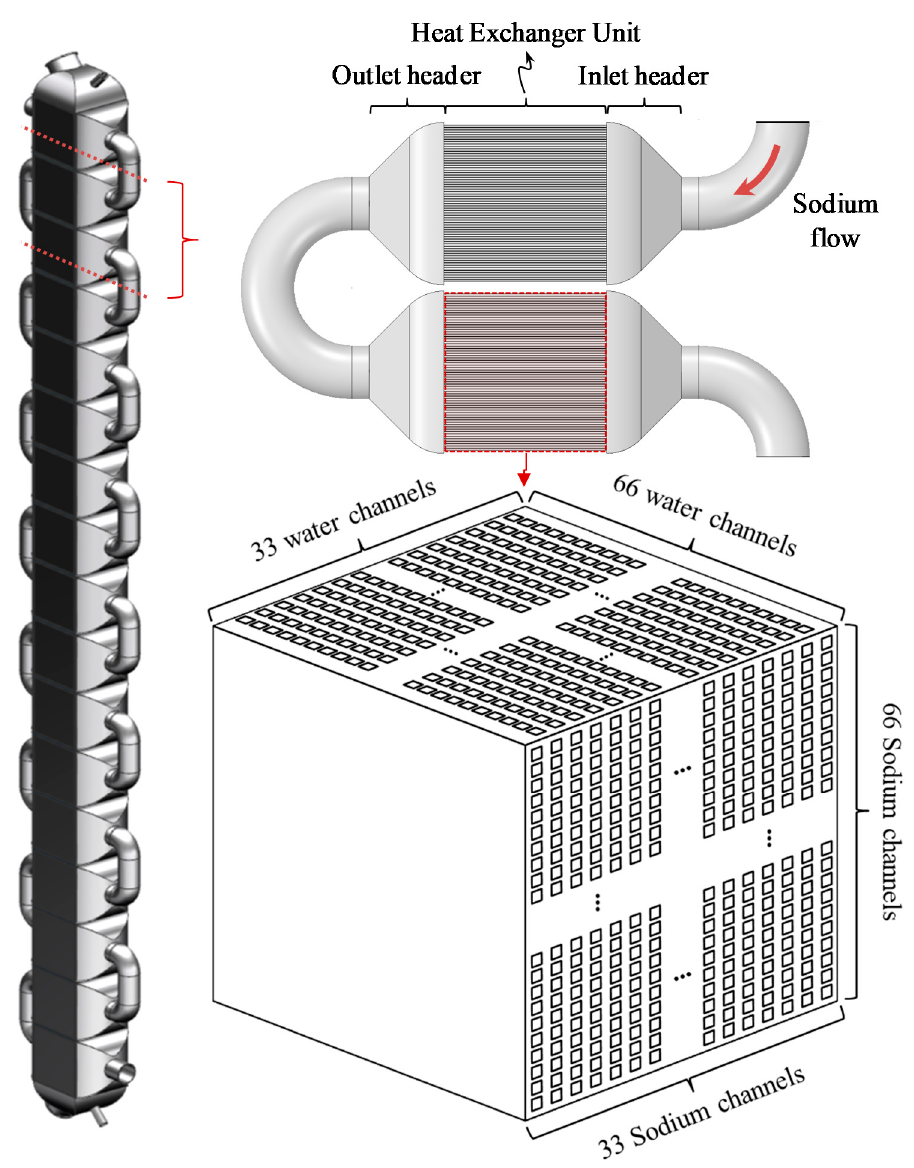
Figure 1. Schematic diagram of the copper-bonded steam generator for sodium-cooled fast reactor.